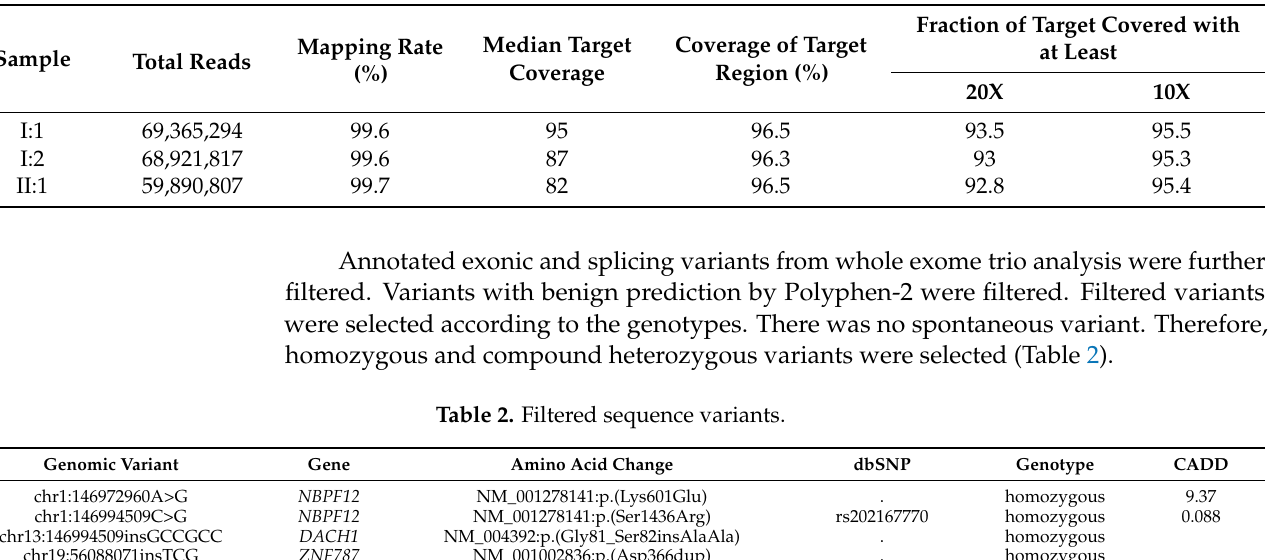
Table 1. Statistics for whole exome sequencing.